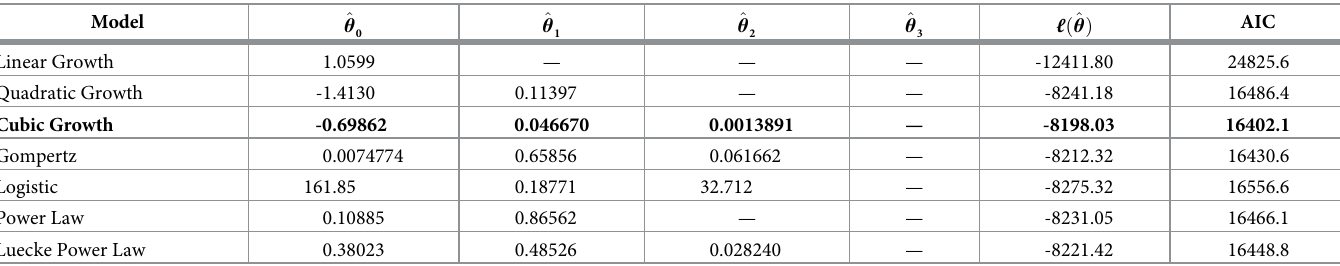
Table 19. Fetal liver mass models (g vs. fetal mass in g for power law models, g vs. gestational age in weeks for all other models). Model